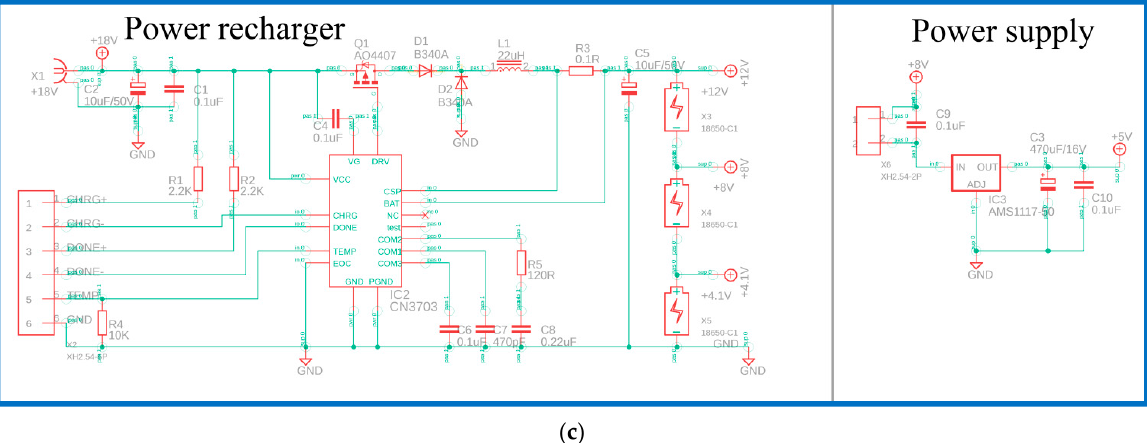
Figure 2. ( a ) The photograph of the bare printed circuit board for thermal control. It is composed of ( b ) a microcontroller, heating module, sensing module, LCD display, ( c ) power supply, and power recharger.